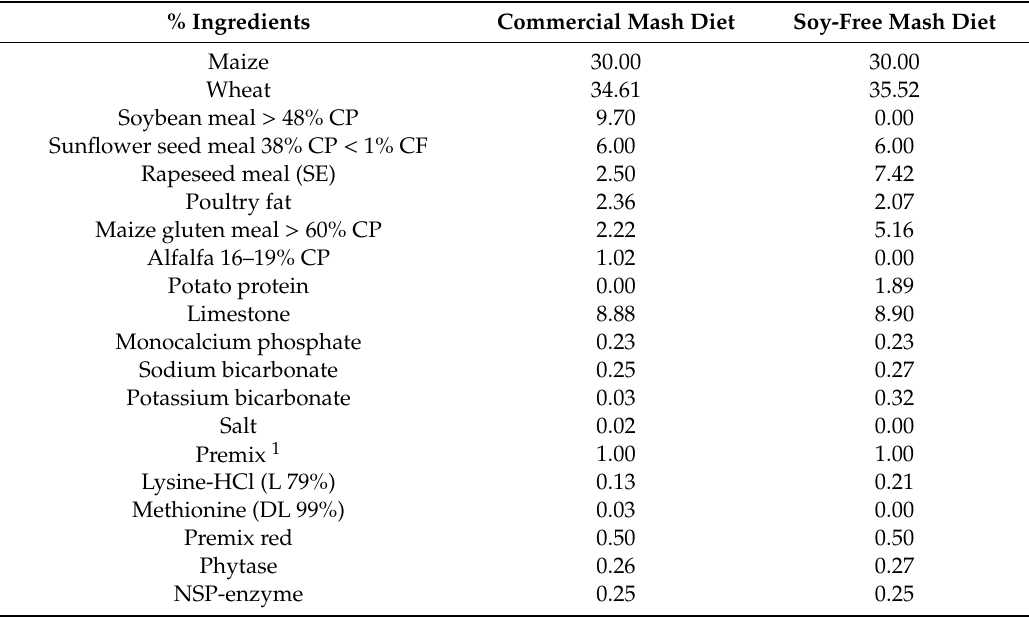
Table 2. Ingredient composition of experimental diets.